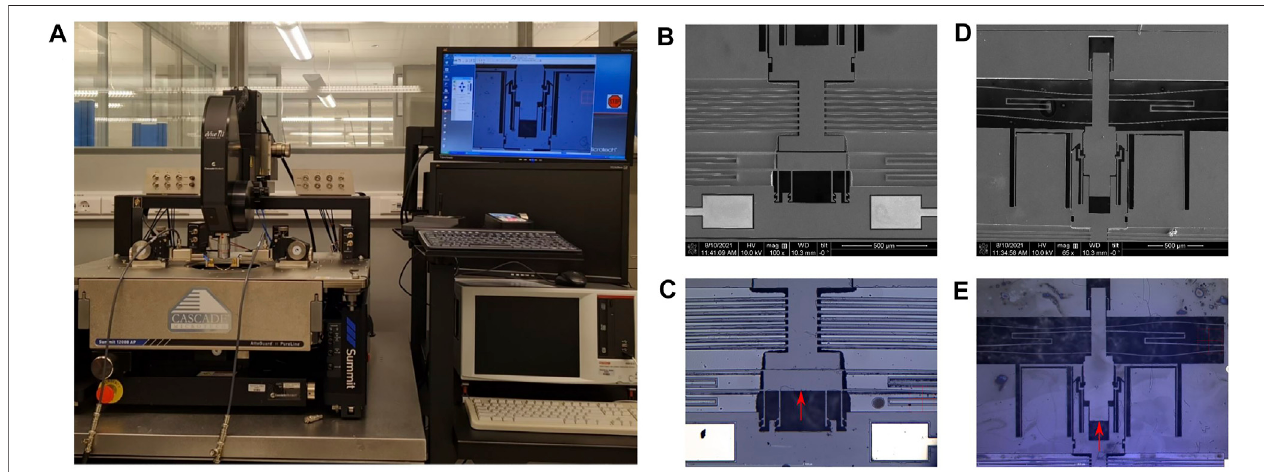
FIGURE 7 | (A) Probe station used in the experiments for power supply and micromanipulation via probe needles under a microscope. (B) SEM image of the as- fabricated bottom stop-block. (C) Optical image of the armed con fi guration of the bottom stop-block. (D) SEM image for the as-fabricated top stop-block. (E) Optical image of the armed con fi guration of the top block-part in a multistable